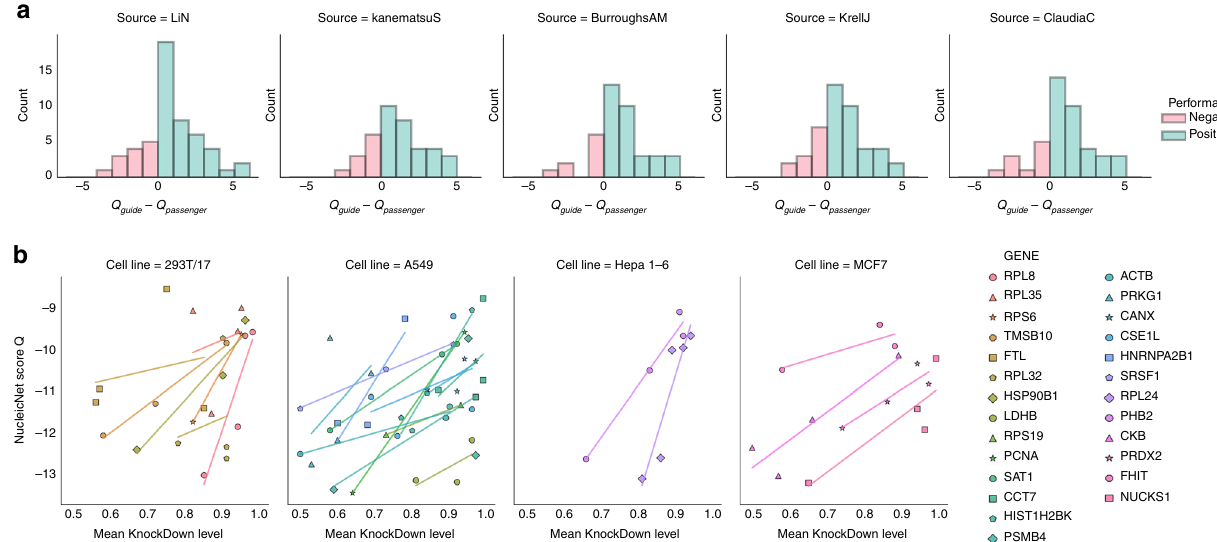
Fig. 5 NucleicNet predictions agree with in vivo experiments on Ago2. a Histogram of the difference in the NucleicNet score between the guide and the passenger strands from fi ve different cell lines, namely four from human (BurroughsAM: acute monocytic leukemia THP-1 26 , KanematsuS: colon cancer DLD 27 , KrellJ: colon cancer HCT116 28 and ClaudiaC: T cell leukemia 29 ) and one from mouse (LiN: neuroblastoma N2a 30 ). Bars with positive difference values are highlighted in green else if negative in red. b Comparing the NucleicNet score with benchmark mean knockdown levels of shRNA targeting 26 genes in four different cell lines